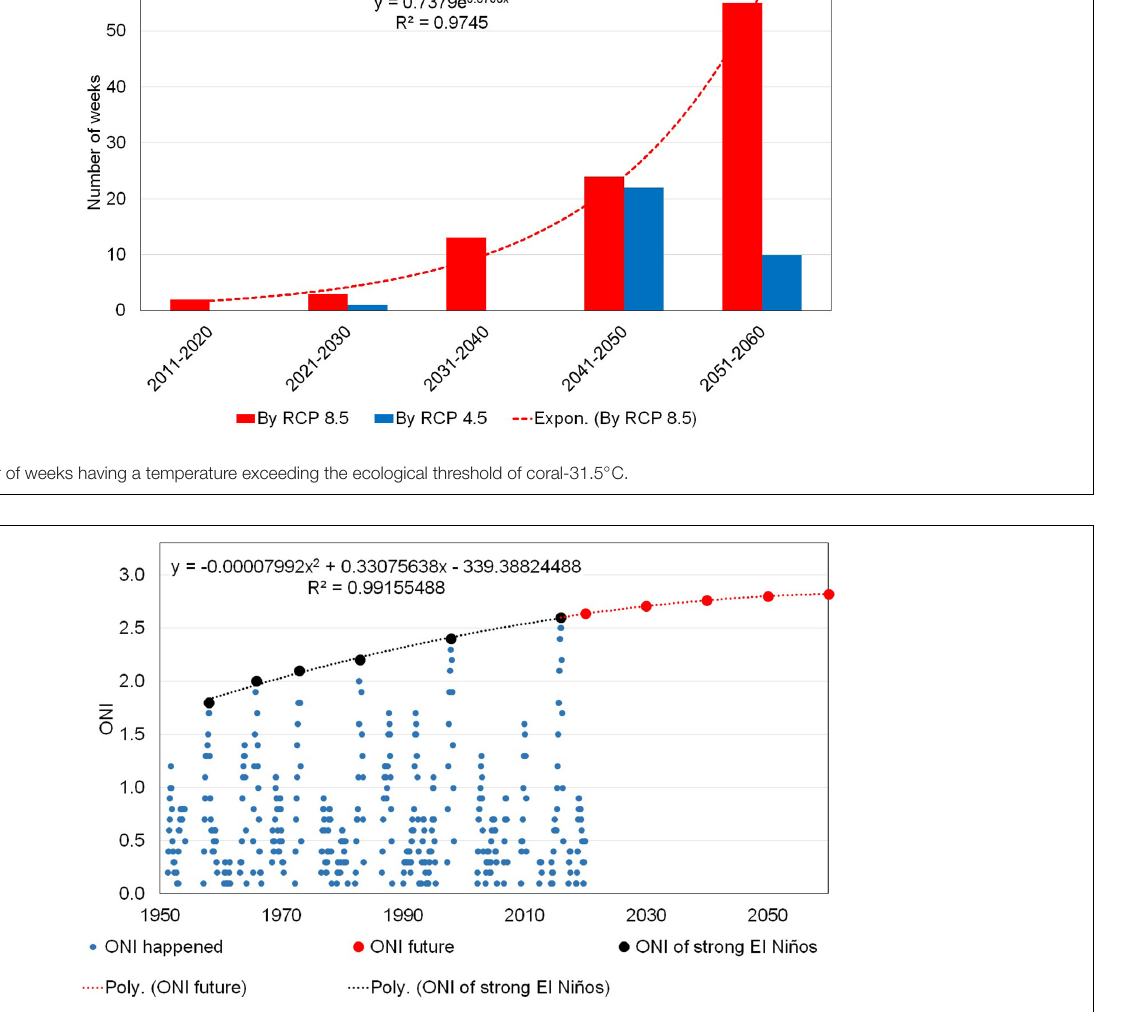
FIGURE 6 | Oceanic Nino Index values for 1958–2020 (blue clots). Strong and powerful ElNmos (Oceanic Nino Index > 1.5) are shown with red dots. The line shows the observed trend of strong and powerful events; this is extrapolated to illustrate possible